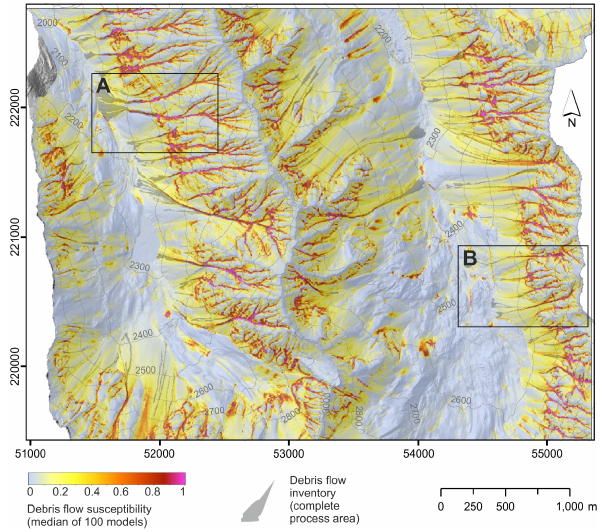
Fig. 6. Part of the susceptibility map (for full extent, see Supple- ment) of the ZBT and LT areas. The susceptibility values represent a model ensemble, specifically the median value of 100 models es- timated from 100 random samples ( n =350 non-event cells) in the ZBT area. Insets A and B refer to map sections in Fig.